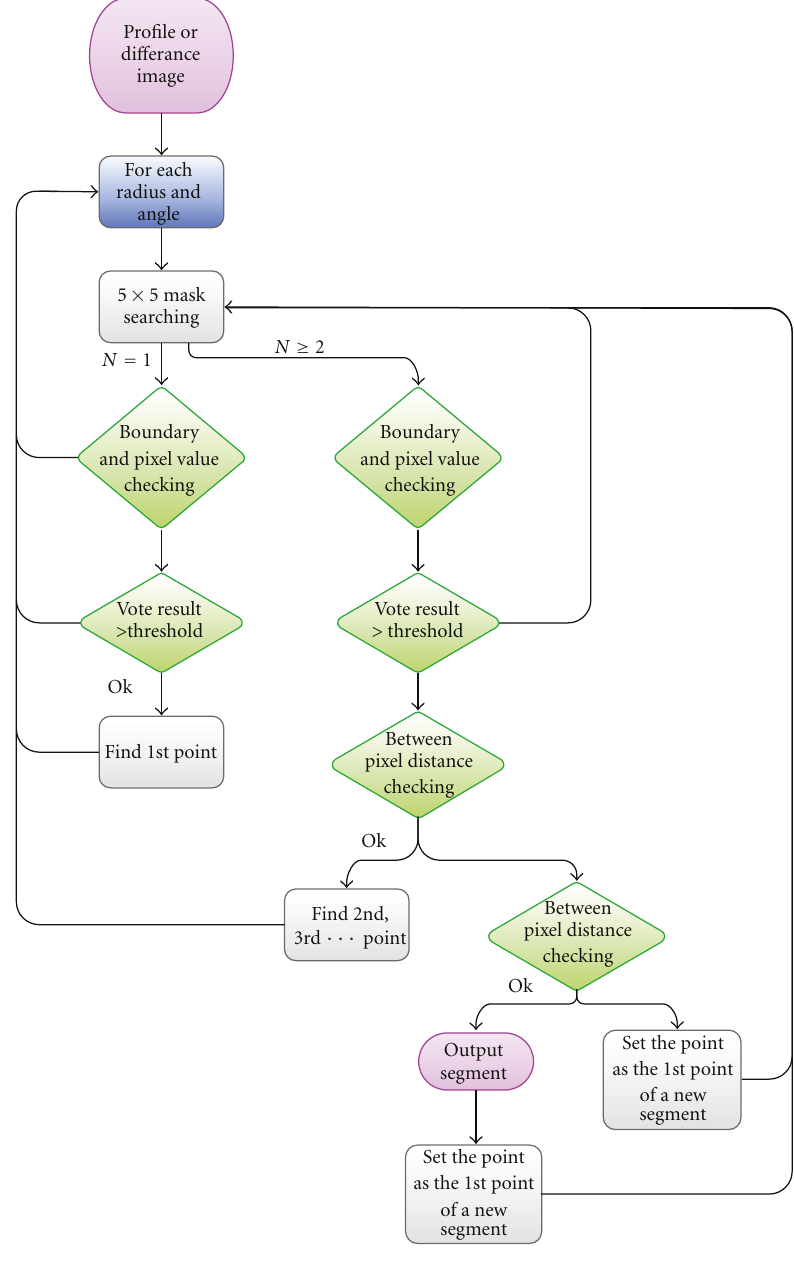
Figure 14: The flow chart of feature